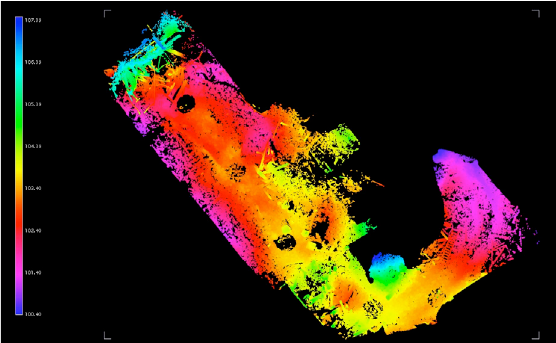
Figure 13: Volumetric analysis on the ruins inside the church Moreover, we have data that can be used to evaluate the structural reaction of the walls when the ruins will be